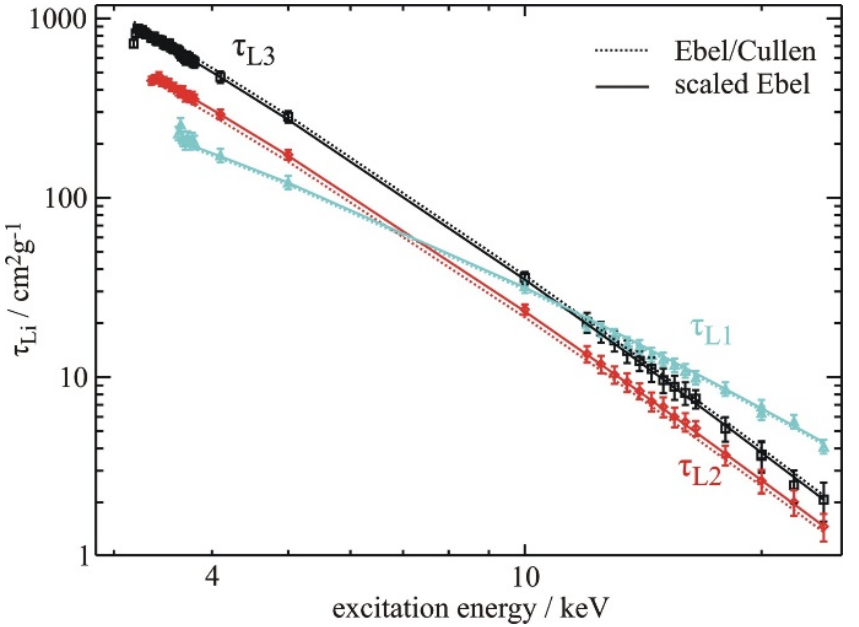
Figure 5. Experimentally determined PCS for the three Pd-L subshells as compared to theoretical Ebel/Cullen data. For the sake of comparison, the Ebel data have been scaled by 0.95 for the L3, 1.08 for the L2, and by 1.03 for the L1 PCS data, respectively.